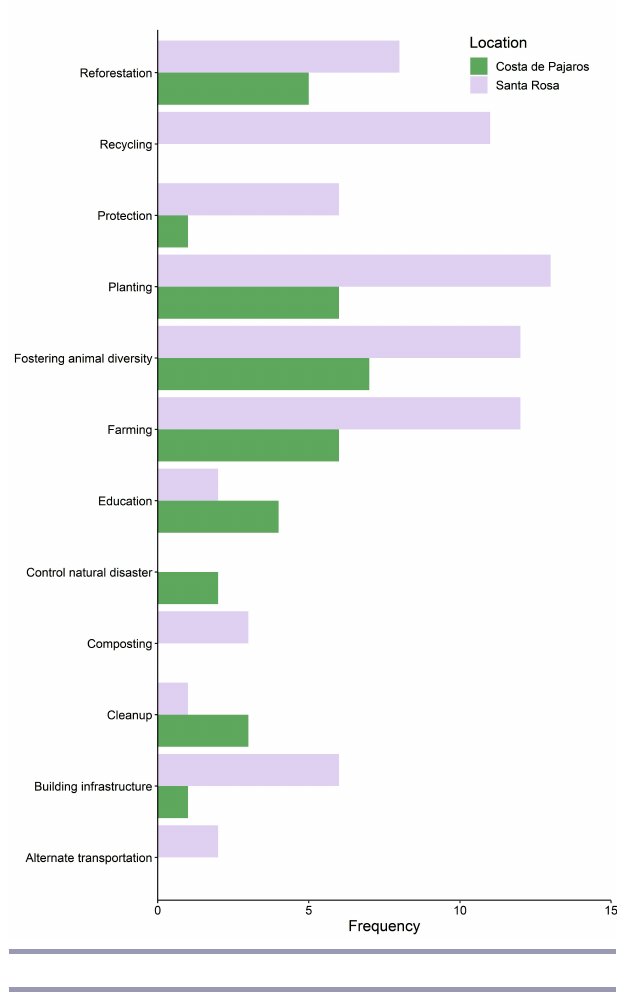
Fig. 4 . Code breakdown of responses to the question, “What do you do in your daily life to help conserve the environment?” Frequency refers to the number of times a code was raised by different members of the community.